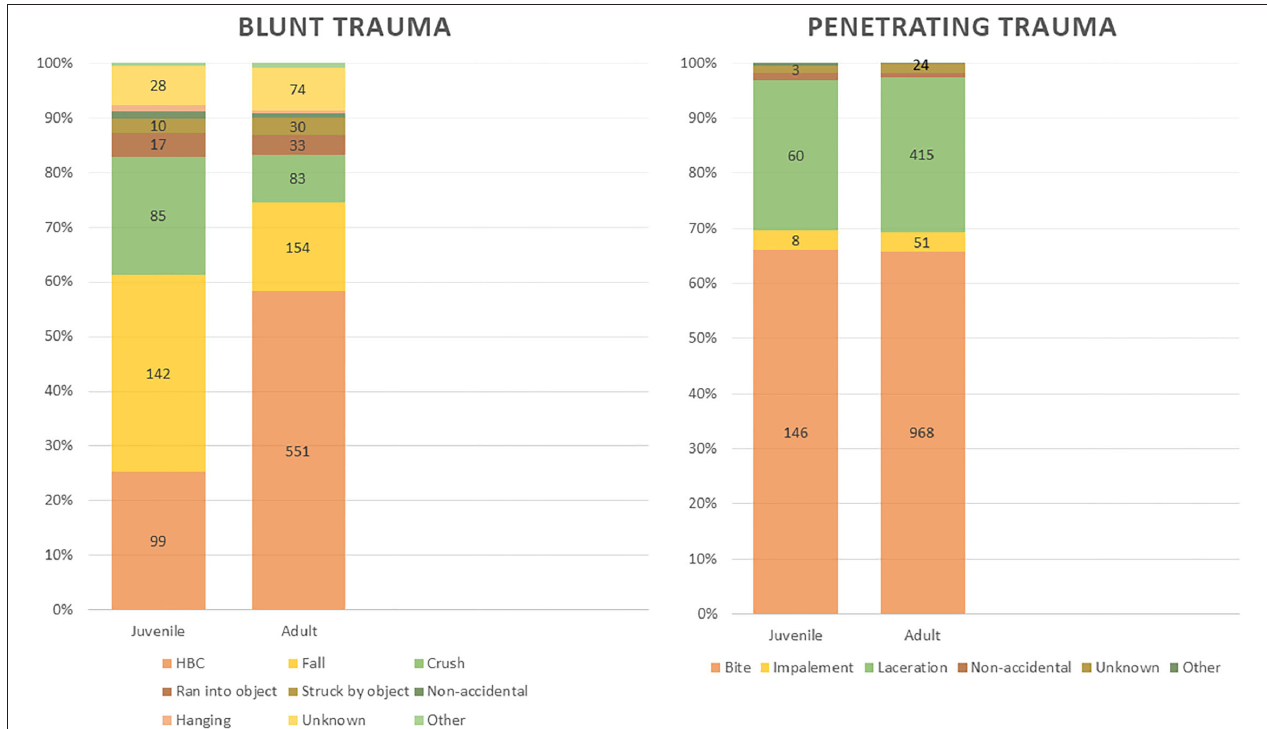
FIGURE 4 | Penetrating and Blunt Trauma subtype distribution of juvenile and adult patients for all time